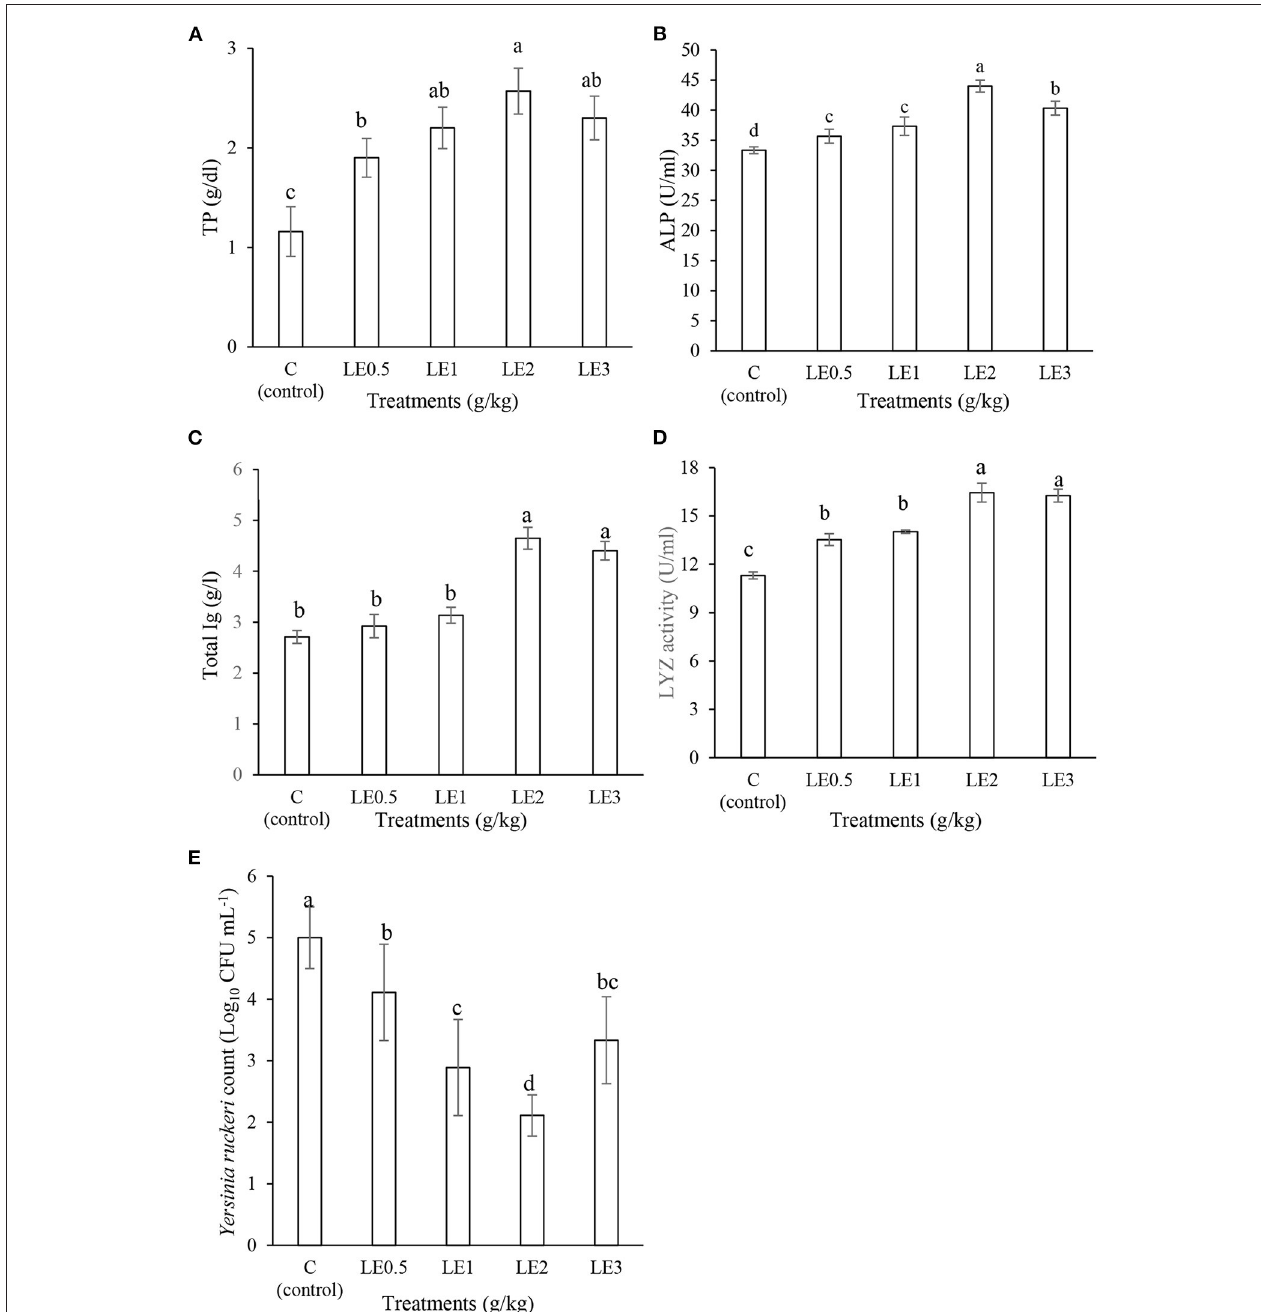
FIGURE 2 | Evaluation of the skin mucosal immunological values of total protein (TP) (A) , alkaline phosphatase (ALP) (B) , total immunoglobulin (Ig) (C) , lysozyme activity (LYZ) (D) , and mucus bacterial count (E) in rainbow trout fed with different levels of licorice extract (LE) supplemented diets. Bars assigned with the same superscripts are not significantly different ( P > 0.05). Values are presented as the mean ± SD ( n =